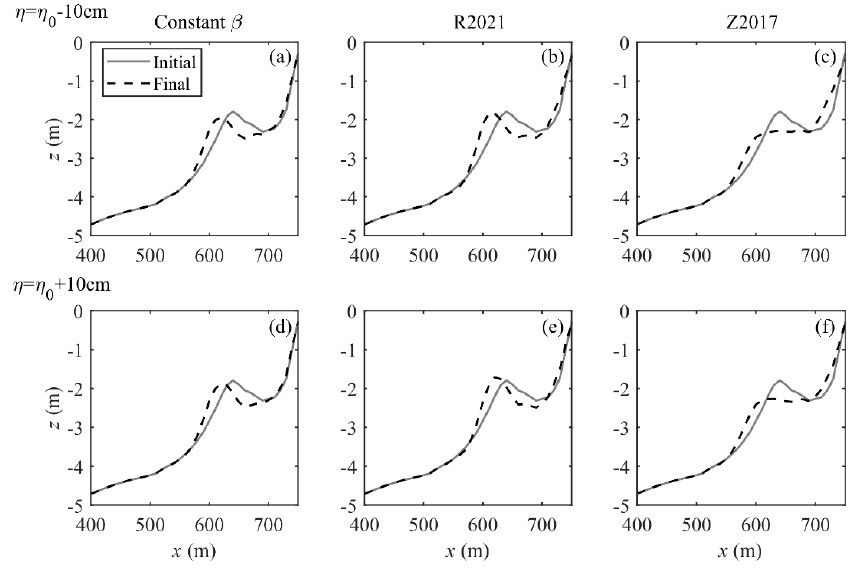
Figure 11. Comparisons of beach profile predicted by constant roller slope (a, d) and the roller slope of R2021 (b, e) and Z2017 (c, f) under two different sea levels. Figures 11a,b,c are calculated with η 0 - slope of R2021 ( b , e ) and Z2017 ( c , f ) under two different sea levels. Figure 11a–c are calculated 10 cm, and figures 11d,e,f are calculated with η 0 +10 cm. with η 0 − 10 cm, and Figure 11d–f are calculated with η 0 + 10